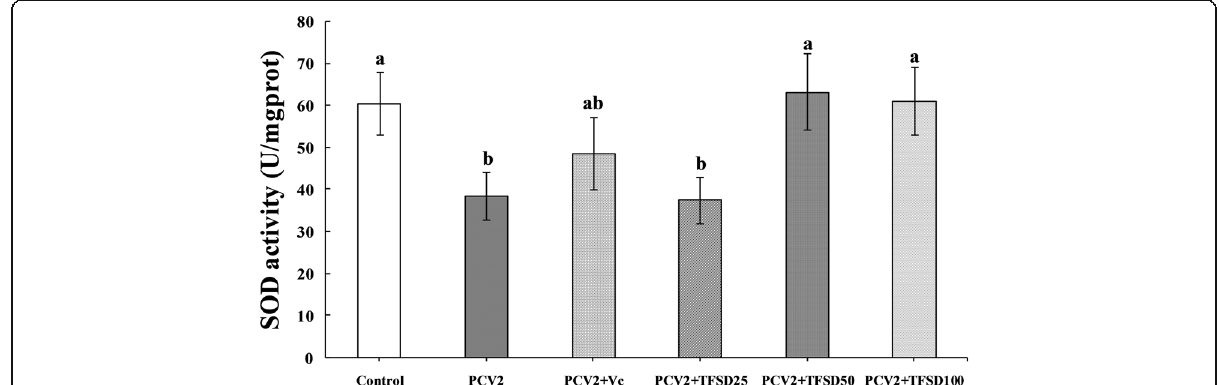
Fig. 4 Effect of TFSD on SOD activity in PCV2 infected RAW264.7 cells. Data are presented as mean ± S.D. Bars with different letters are statistically different ( P < 0.05). Control: cells without PCV2 infection and drug treatment; PCV2: cells infected with 10 2.7 TCID 50 PCV2; PCV2 + Vc: cells treated with 100 μ g/mL of vitamin C after PCV2 infection; PCV2 + TFSD25 – 100: cells treated with TFSD at concentrations of 25, 50 or 100 μ g/mL after PCV2 infection,